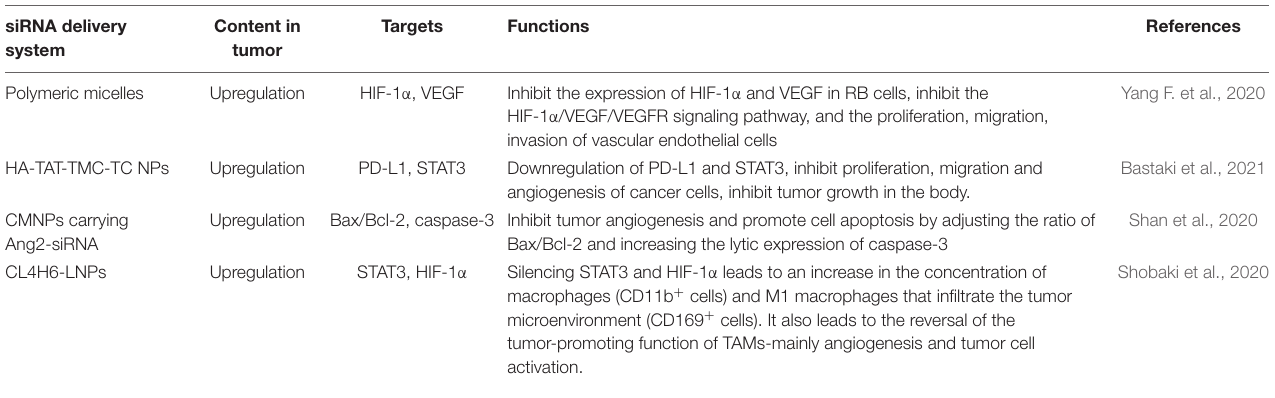
TABLE 4 | siRNA delivery system, target and function of regulating tumor